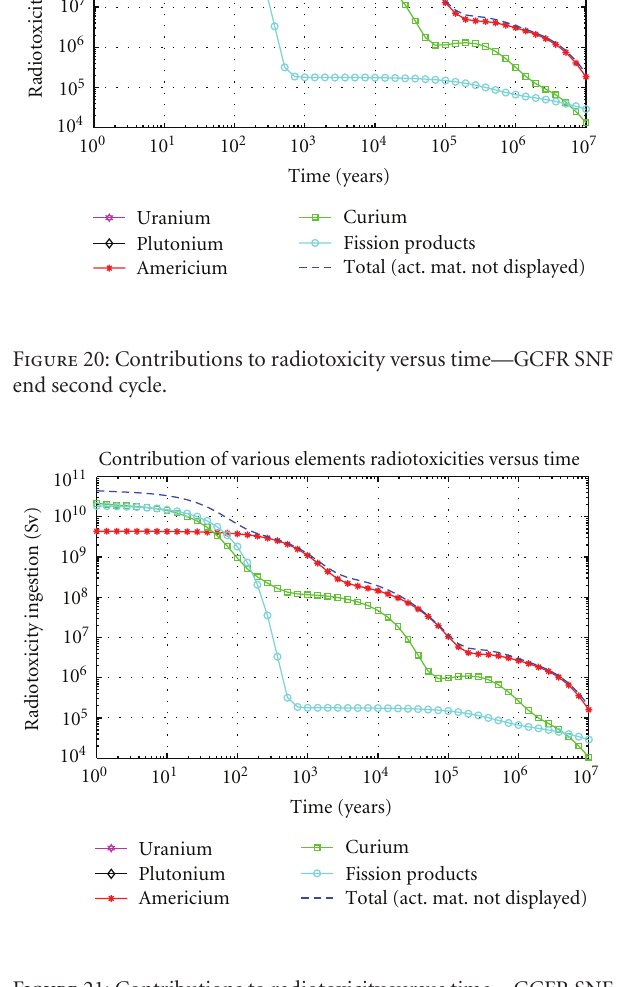
Figure 21: Contributions to radiotoxicity versus time—GCFR SNF end third